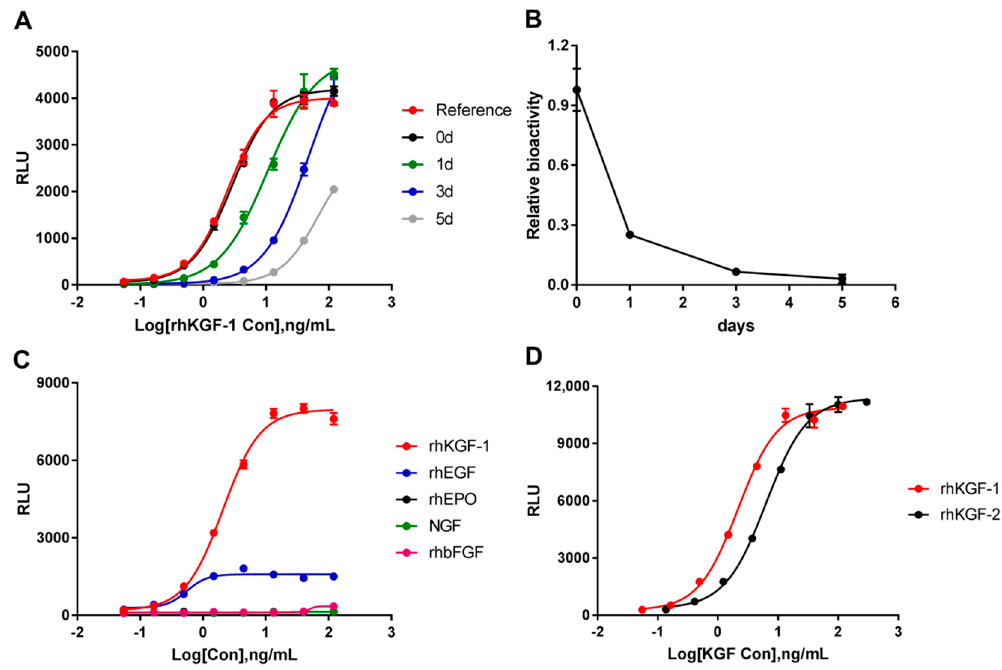
Figure 3. The specificity of rhKGF-1 bioassay. ( A ) The sigmoidal curves of untreated and forced degradation of rhKGF-1. The forced degradation was induced by 37 ◦ C incubation for 1 d, 3 d and 5 d. ( B ) The relative bioactivity of forcibly degraded rhKGF-1. The relative bioactivities were decreased gradually with time of degradation. ( C ) The responsiveness of cells to rhKGF-1 and to the therapeutic cytokines rhEGF, rhEPO, NGF, and rhbFGF. ( D ). The responsiveness of cells to rhKGF-1 and rhKGF-2. RLU = Relative Luciferase Units. The mean ± SD is shown in each curve.